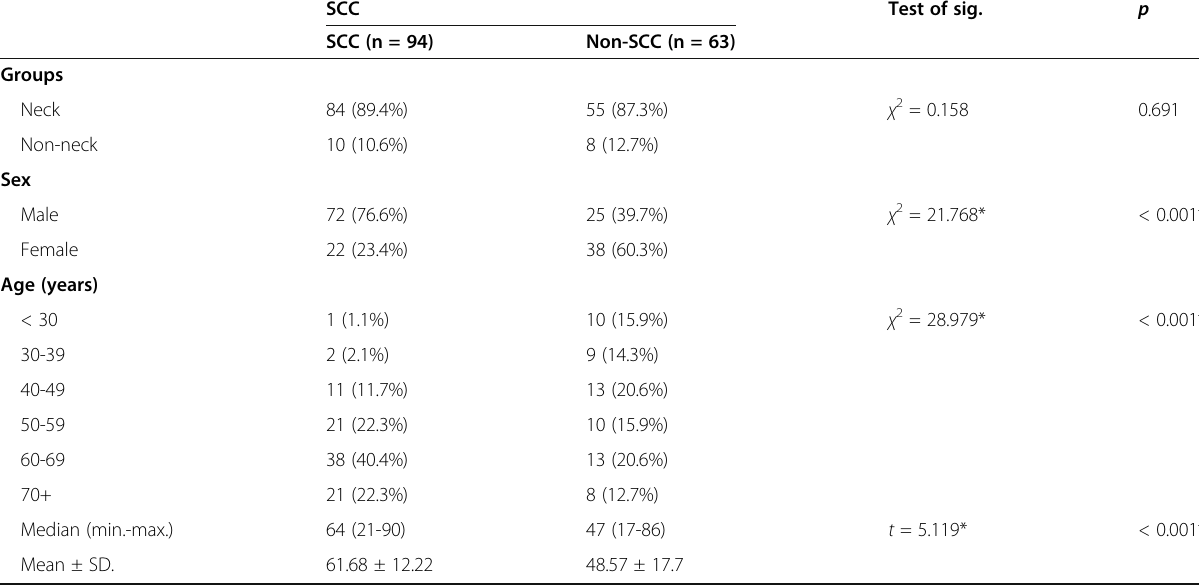
Table 2 Comparison between the two studied groups according to demographic data